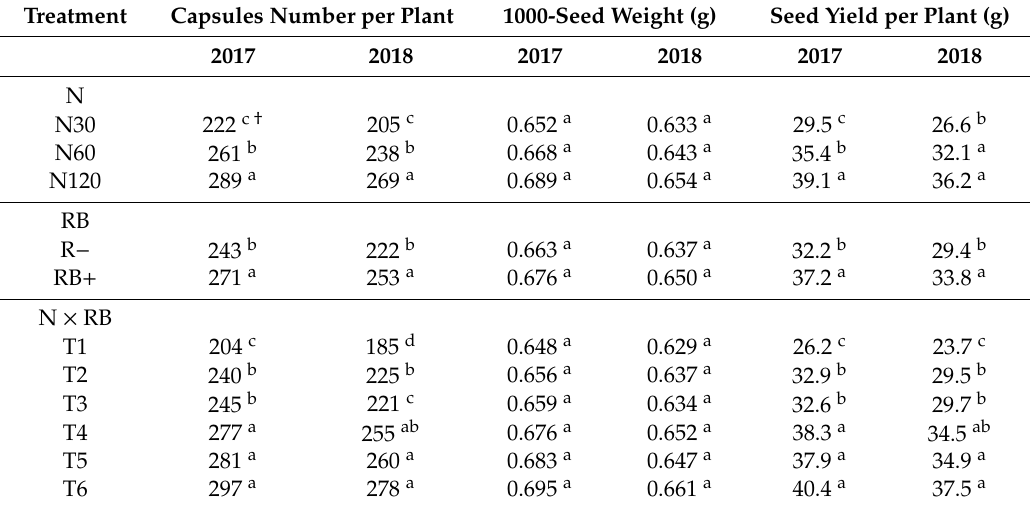
Table 6. E ff ects of mineral nitrogen fertilizer (N) and Rhizobacterein biofertilizer (RB) on Egyptian henbane seed yield parameters in the growing seasons 2017 and